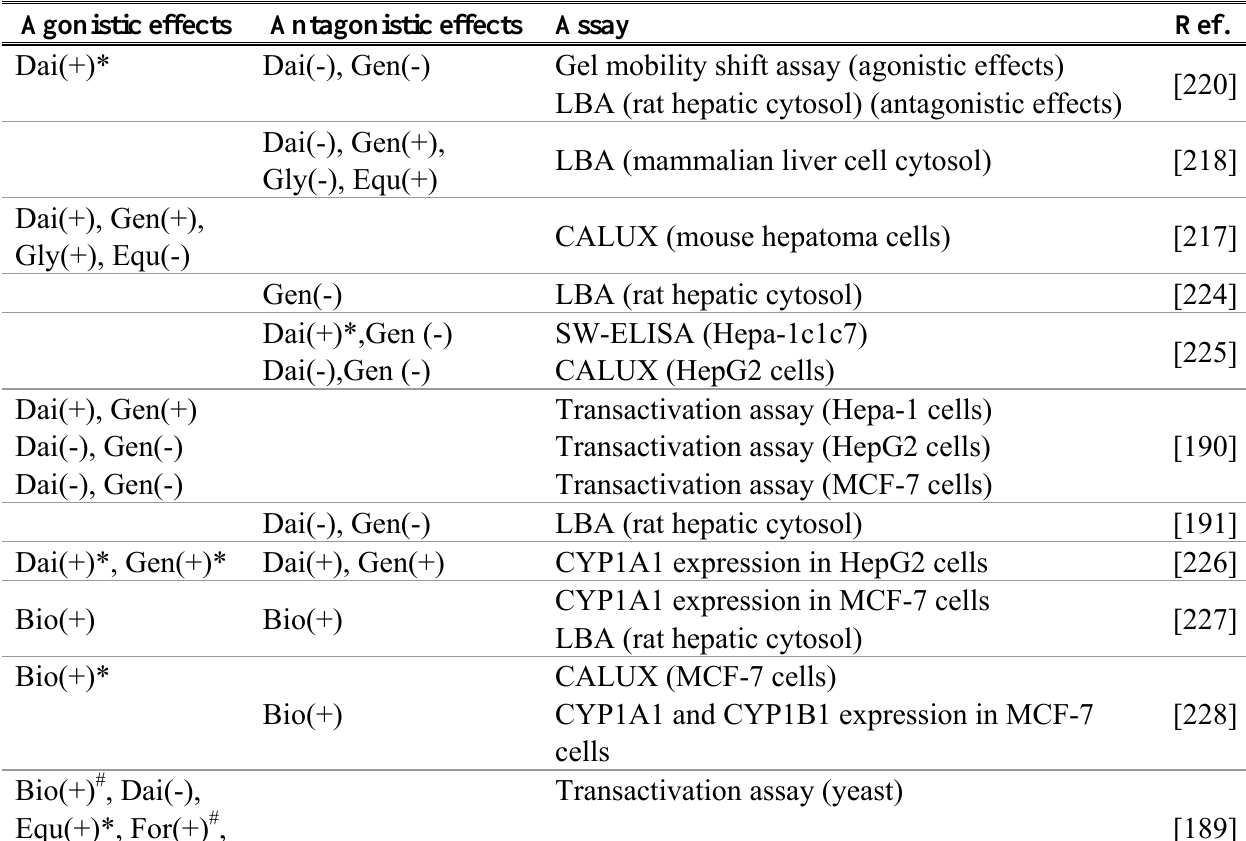
Table 3. Agonistic and antagonistic effects of isoflavones on the